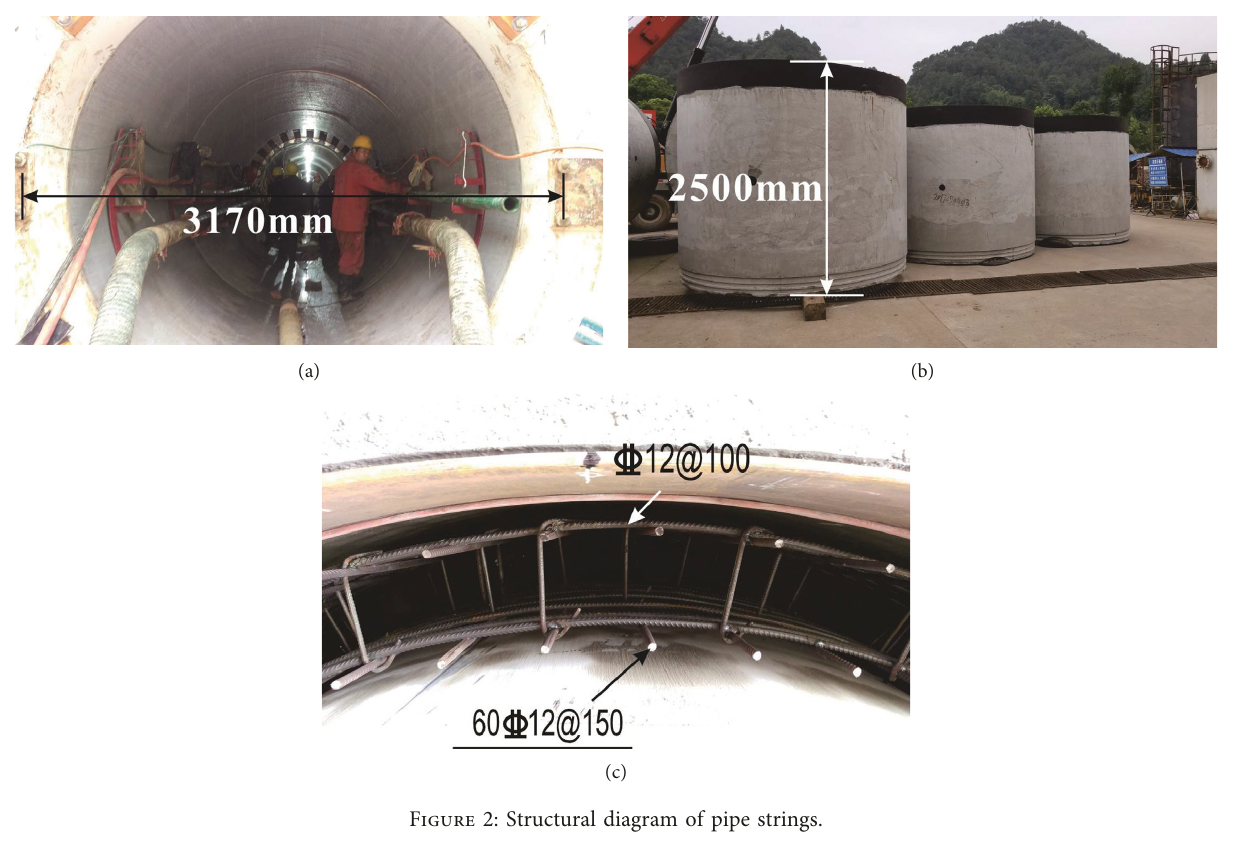
Figure 2: Structural diagram of pipe strings.